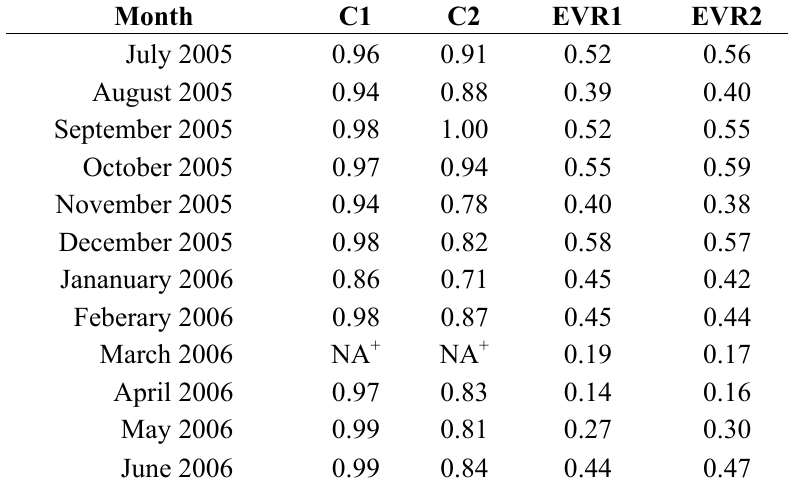
Table 2. Filtrate factor monthly average comparison of the Chambers